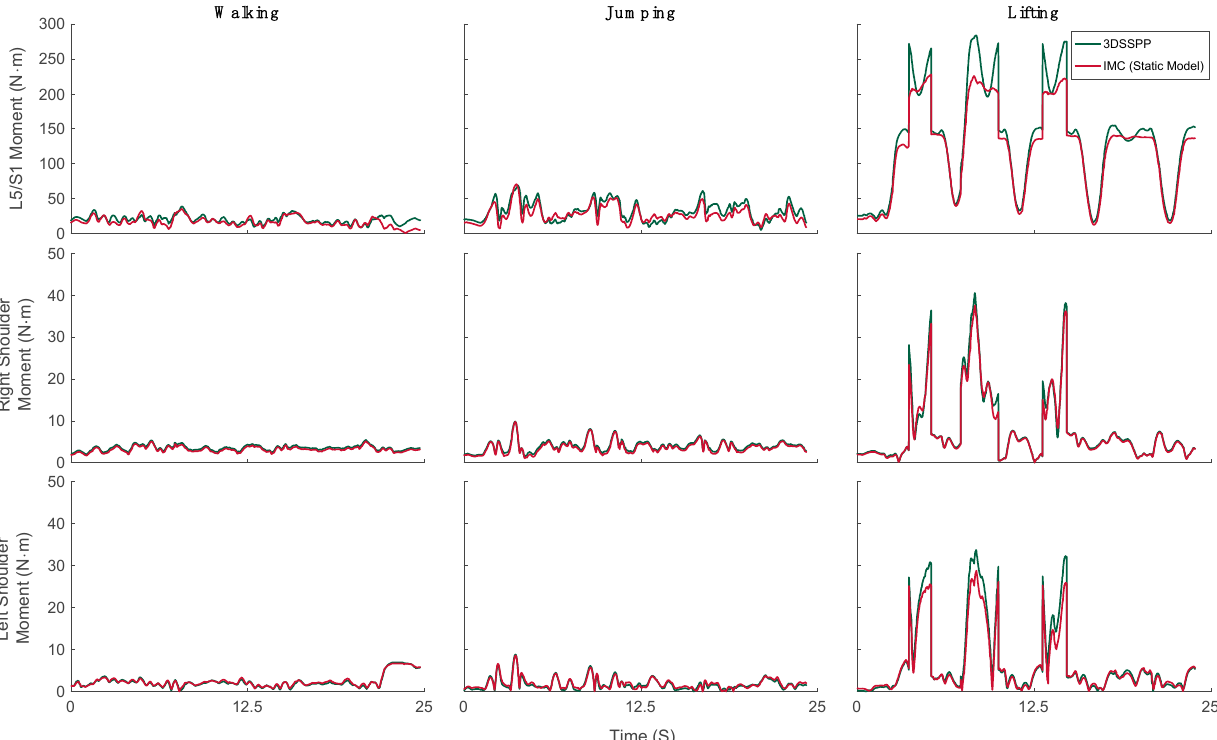
Figure 8. Typical examples of 3DSSPP-calculated (green lines) and IMC model-predicted (red lines) net static moments of L5/S1, right, and left shoulder joints during walking, jumping, and lifting.